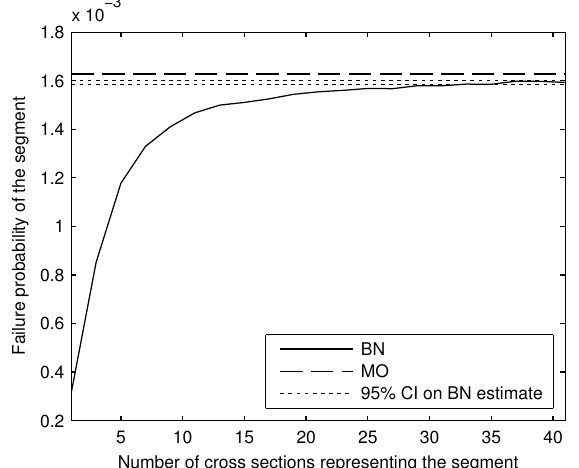
Figure 14. Comparison of posterior segment failure probability estimates computed with the BN and MO methods; 95% confidence intervals on the BN estimate are also indicated.